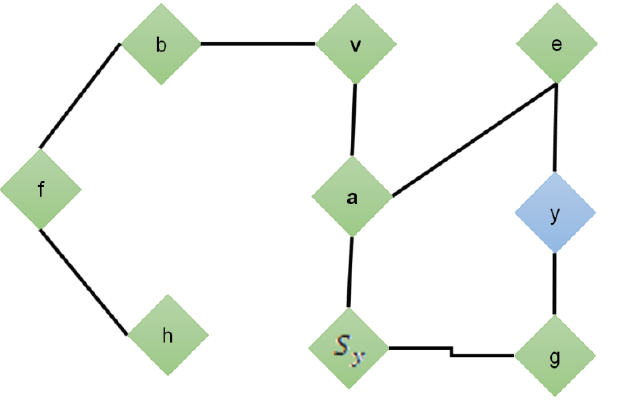
Figure 2. Detecting conflicts .